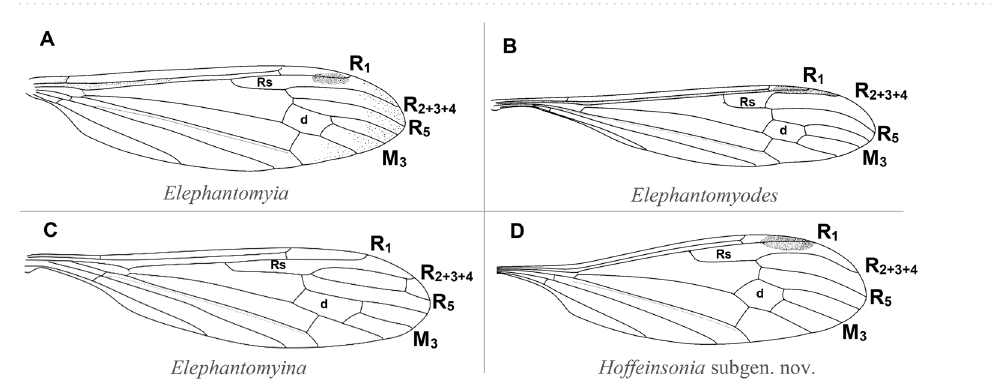
Figure 9. Wing venation of species belonging to different subgenera of genus Elephantomyia : ( A ) Elephantomyia (s. str.) edwardsi Lackschewitz 35 (redrawn 36 ); ( B ) Elephantomyia ( Elephantomyodes ) major major Alexander 4 (redrawn 17 ); ( C ) Elephantomyia ( Elephantomyina ) supernumeraria Alexander 37 (redrawn 2 ); ( D ) Elephantomyia ( Hoffeinsonia ) prima subgen. and sp.